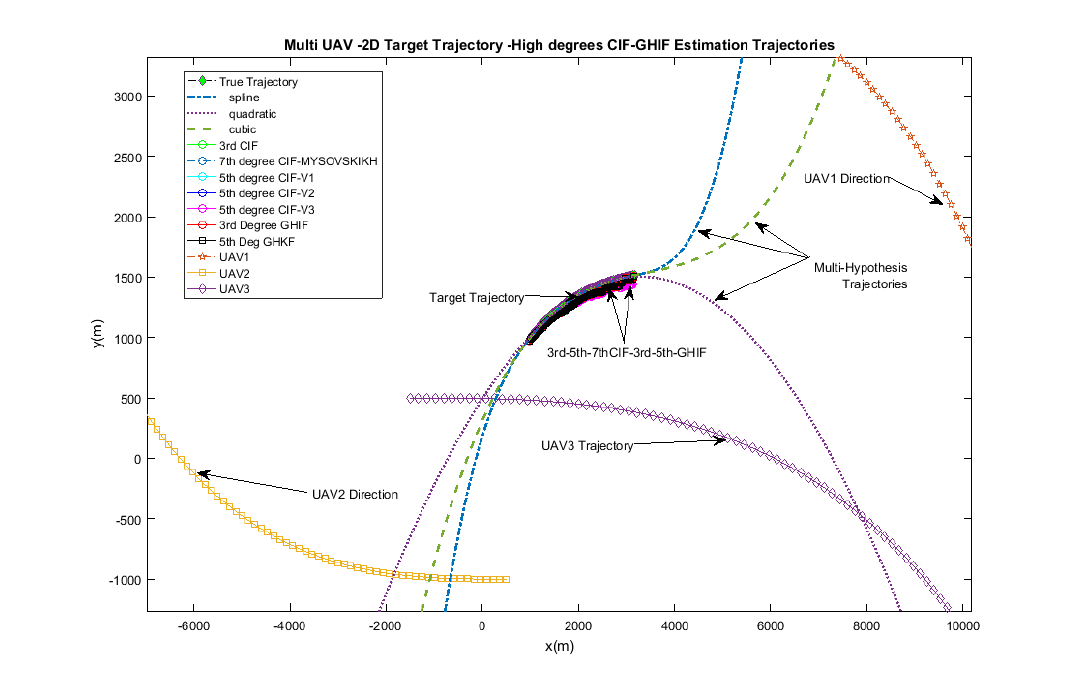
Figure 5. Range rate Doppler-based estimation: UAV1, UAV2, UAV3 trajectories are clearly described and indicated around the target trajectory. In black, 7 th -degree CIF and 5 th -degree GHIF are close to the true target trajectory, 5 th -degree CIFs and 3 rd -degree CIF-GHIF are superposed in pink color with light deviation from the black trajectory estimate. Three possible fitting trajectories (spline, quadric, cubic) are illustrated with discontinuous green, blue, and yellow colors.